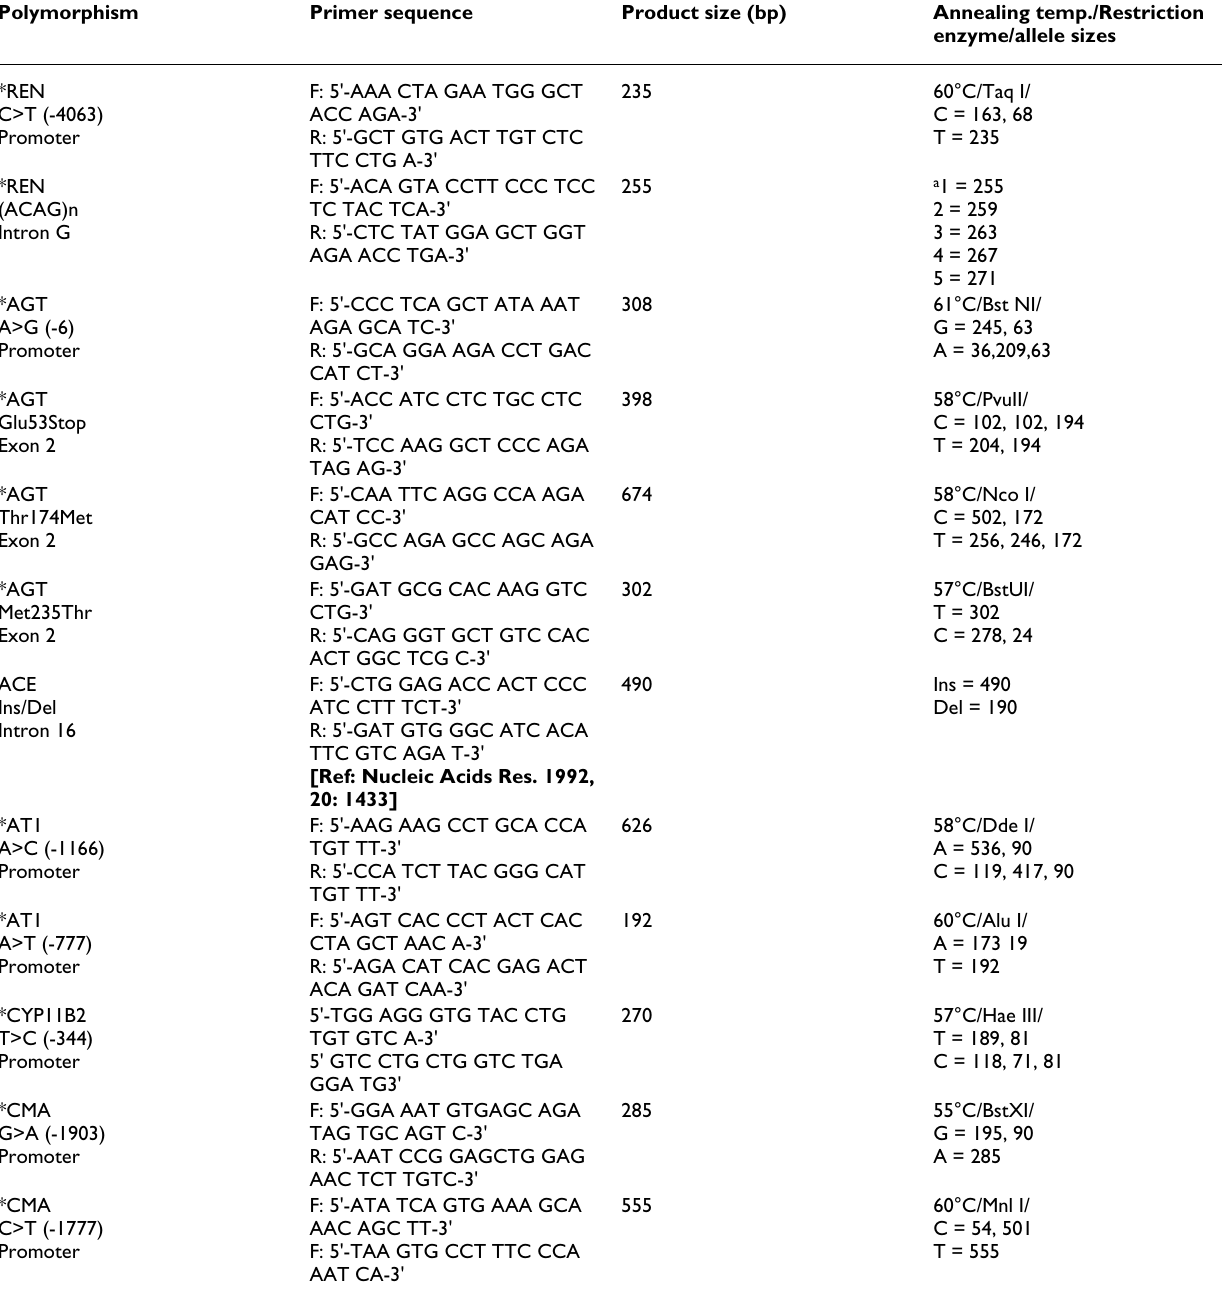
Table 1: SNPs in RAAS pathway genes, their location, primer sequences, PCR conditions and restriction enzyme with product sizes. Polymorphism Primer